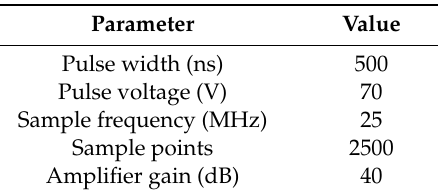
Figure 3. Schematic diagram of the data acquisition system. Table 1. Array controller settings.